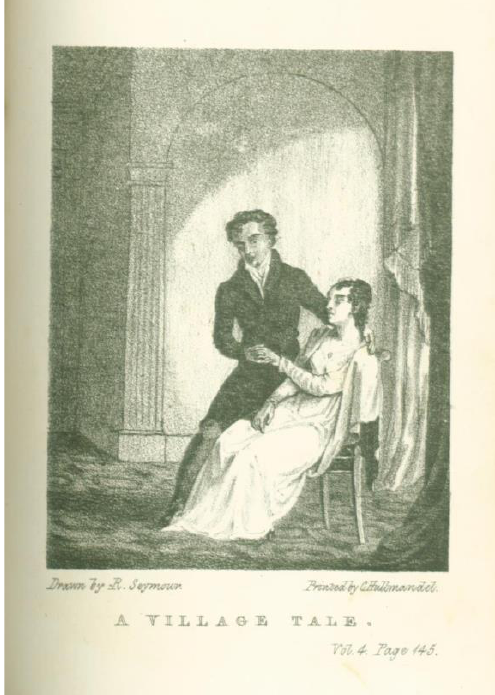
Fig. 1 Robert Seymour. Lithographed illustration in the Pocket Magazine of Classic and Polite Literature , new series (Knight and Lacey, 1826), p.